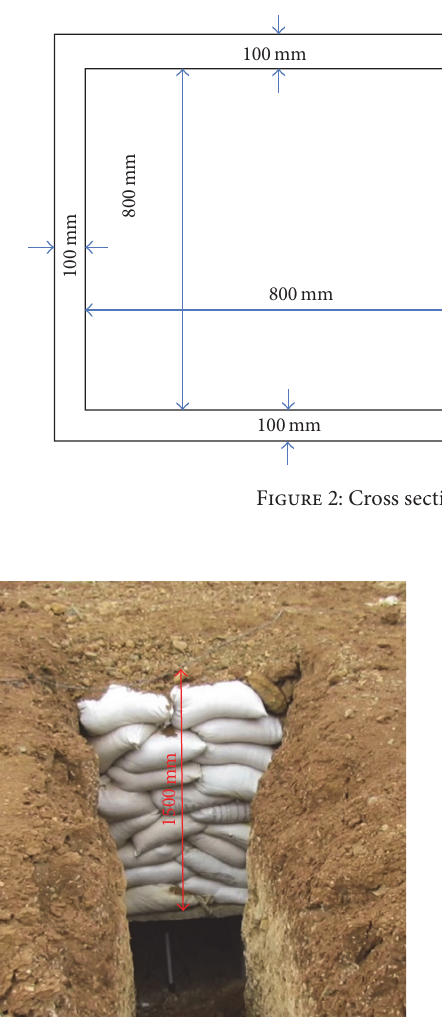
Figure 3: The buried tunnel.